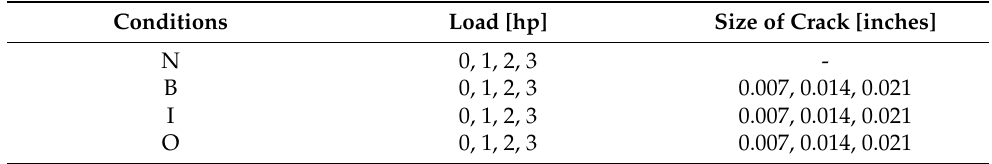
Table 1. Bearing data information for four conditions.